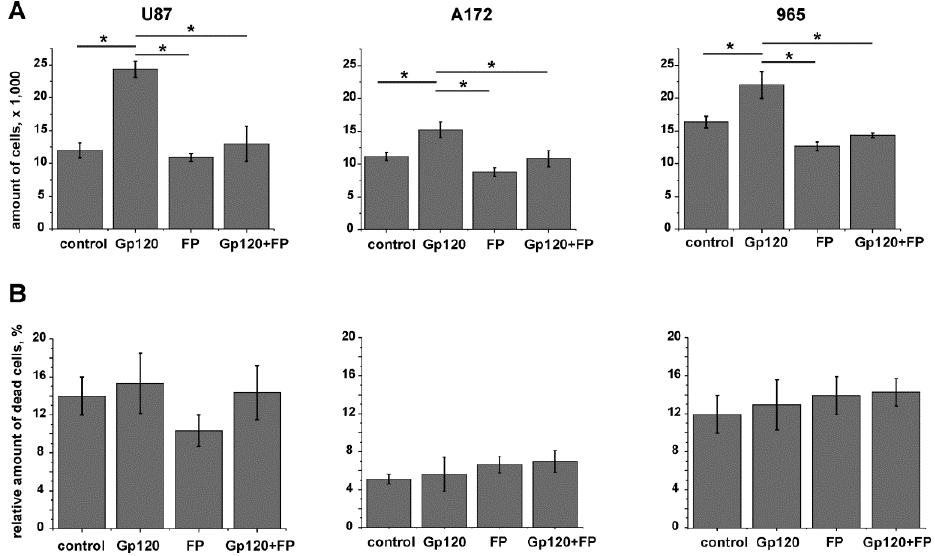
Figure 8. Sodium monofluorophosphate (FP) reverses the effect of gp120-induced proliferation in glioma cells. Experiments were performed in untreated glioma cells and cells continuously treated with gp120 for 10 days. U87 and A172 cell lines and 965 primary glioma cells were investigated. Cells were treated with FP, 0.9 mg/mL, for 24 h and live and dead cells were counted with the use of trypan blue staining. ( A ) Cell viability was evaluated as the total number of live cells grown in 24 h. ( B ) The proportion of dead cells was evaluated as the percentage of the total number of cells. Mean ± S.E. and significant differences from control (*) are shown ( p < 0.05). Unpaired t -tests were used to determine the significance between groups. Six independent experiments ( n = 6) were used for statistical analysis.